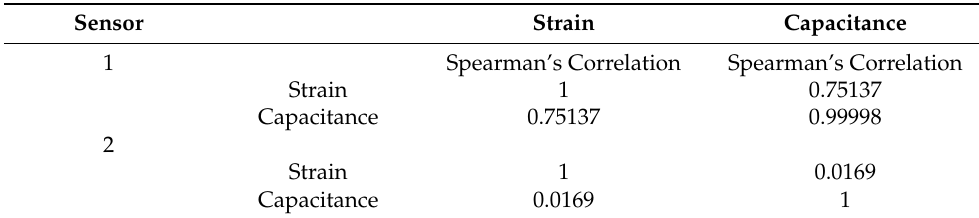
Table 4. Spearman’s Rank Correlation Coefficients for the Peak and Valley Strain and Capacitance for the Two Fatigued StretchFABRIC